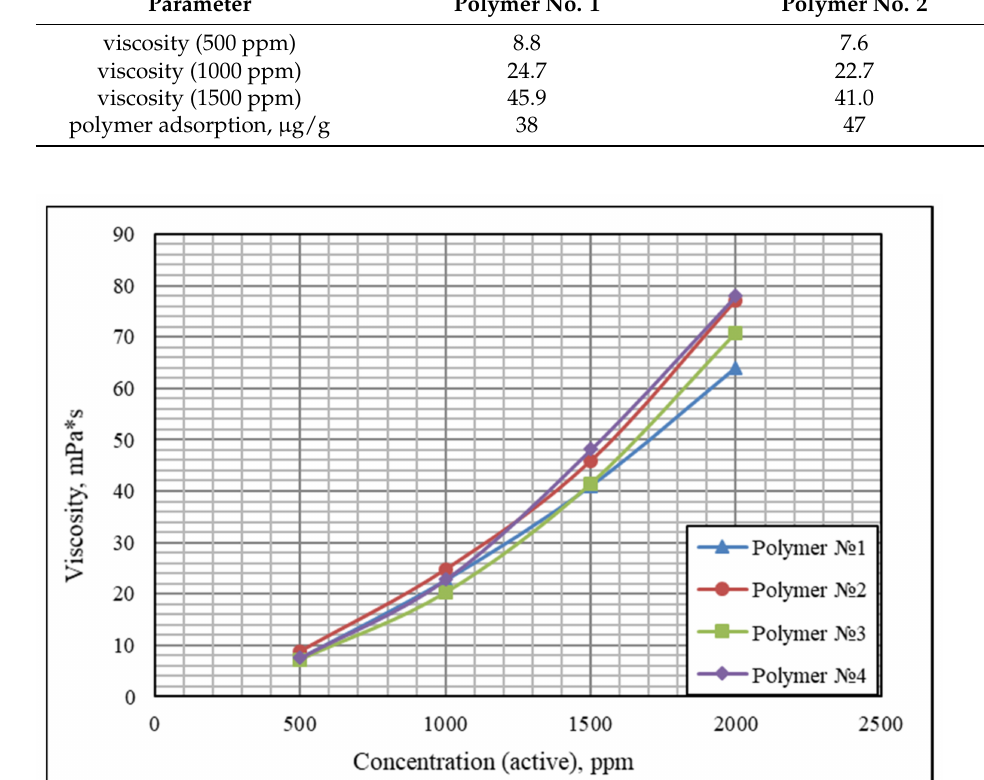
Figure 5. Dependence of polymer solutions on